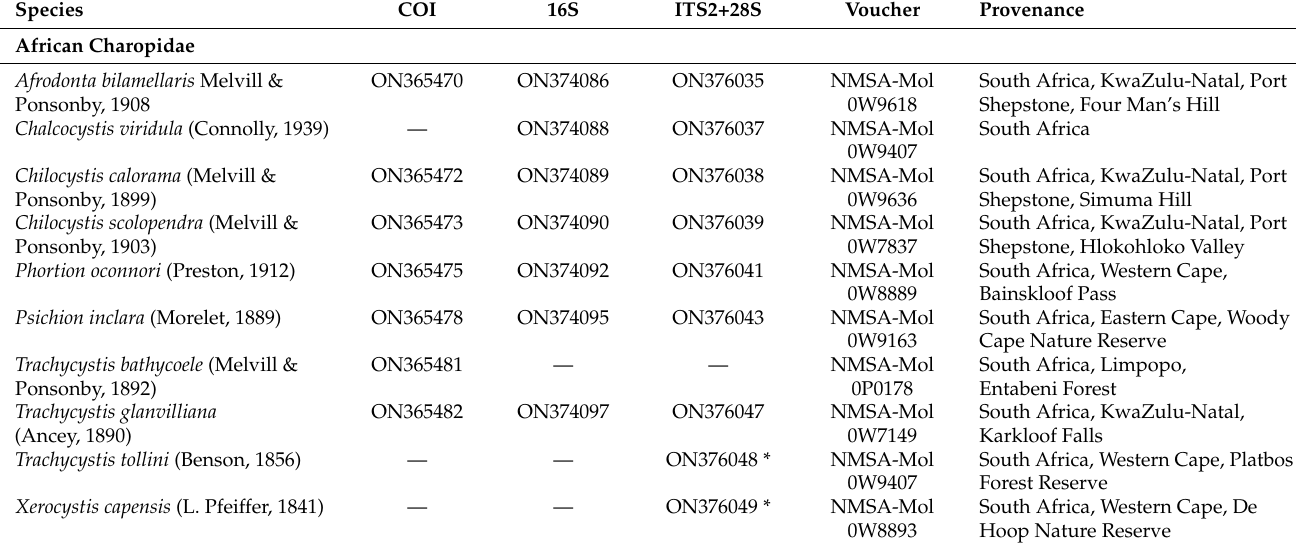
Table 1. List of species used in this study, with GenBank accession numbers for each marker, and voucher data (registration number and locality of provenance). * Fragmentary sequences, excluded from final